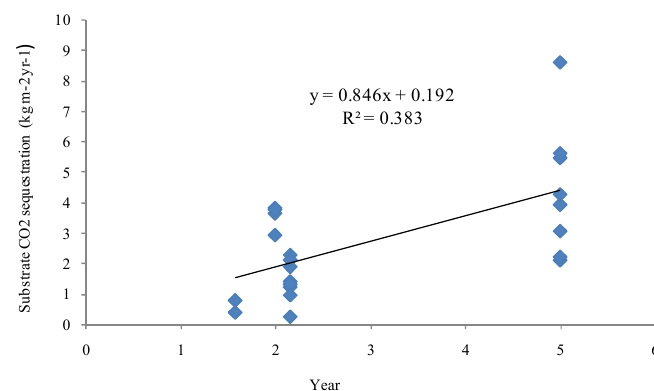
Figure 2. Soil organic carbon dioxide to ~0.3 m soil depth for the CW plant.